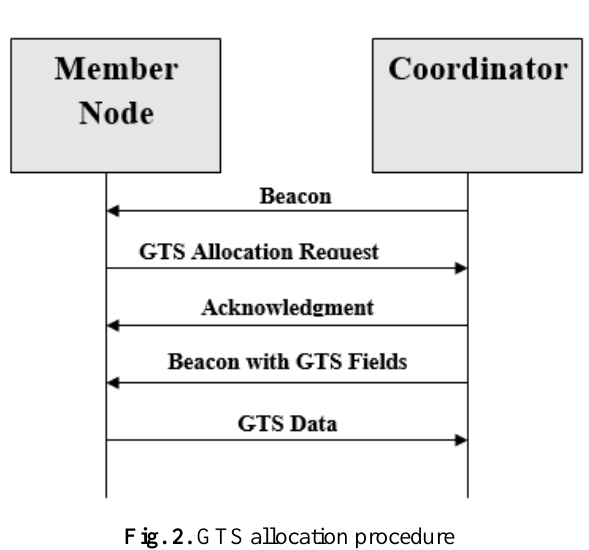
Fig. 2. GTS allocation